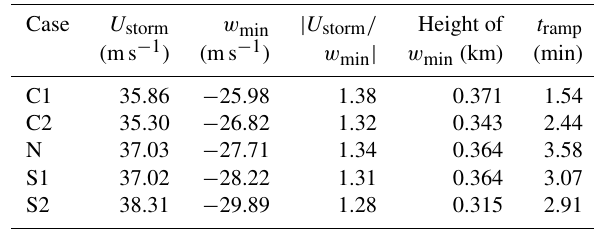
Table 1. Ensemble-averaged maximum event horizontal wind speed, ensemble-averaged maximum event downdraft, and the ra- tio of those two for each case, along with the ensemble average of the time from first sign of divergence at the surface ( ∇ · U sfc